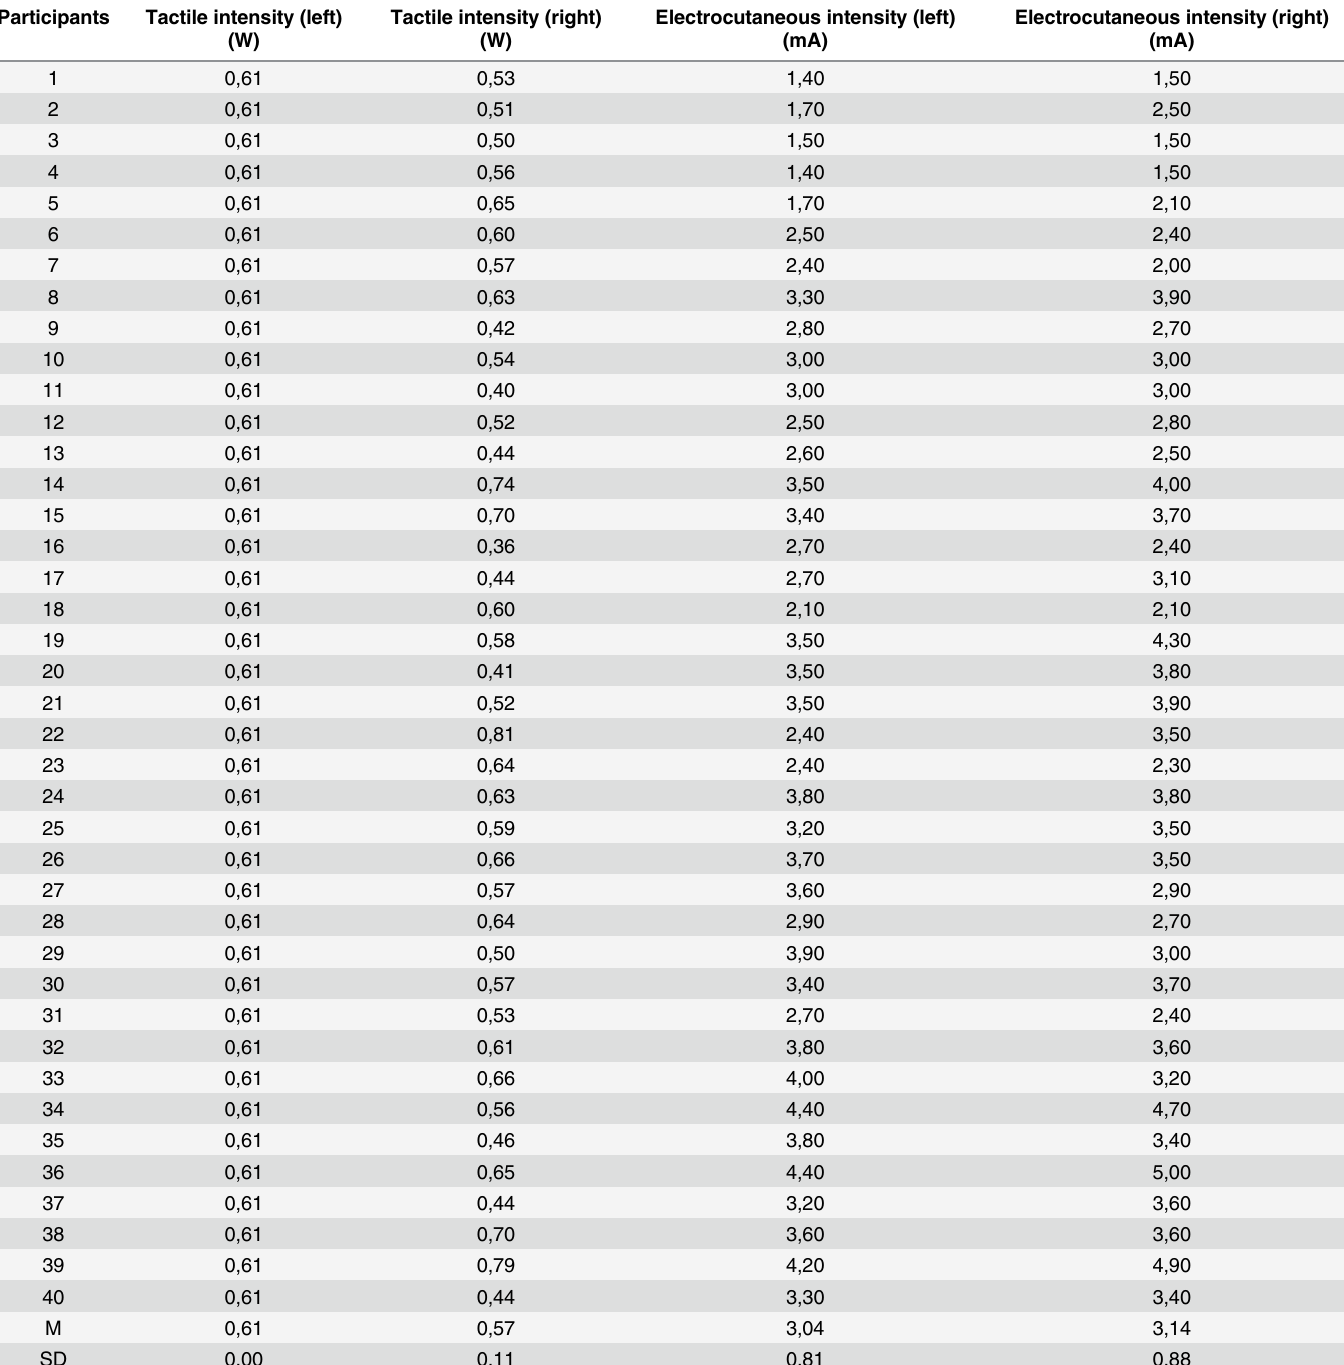
Table 1. Stimulus